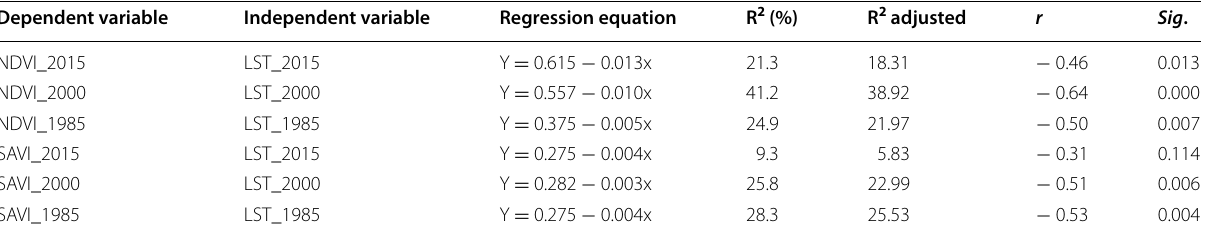
Table 2 Linear regression and correlation coefficients for the relationship between LST and SAVI in 1985, 2000, and 2015